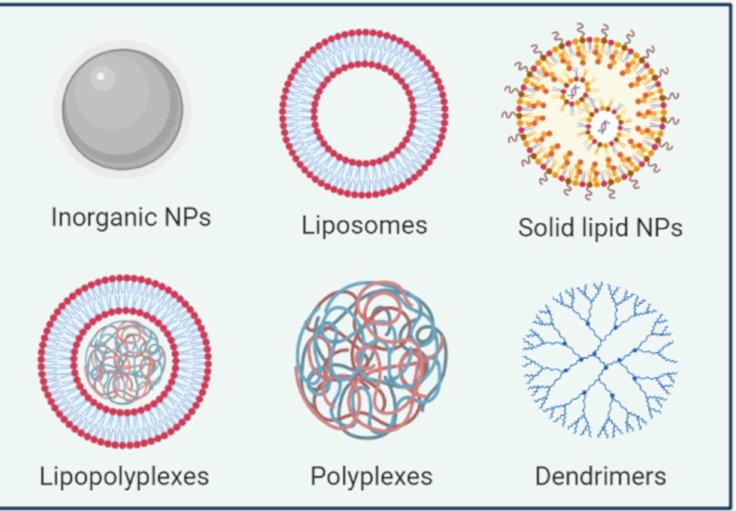
Figure 1. A schematic representation of some nanocarriers used for miRNA